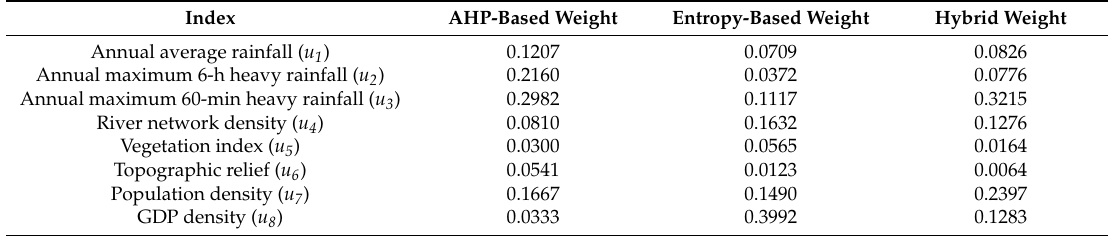
Table 10. Hybrid weight of each index for risk assessment of mountain torrent disaster.